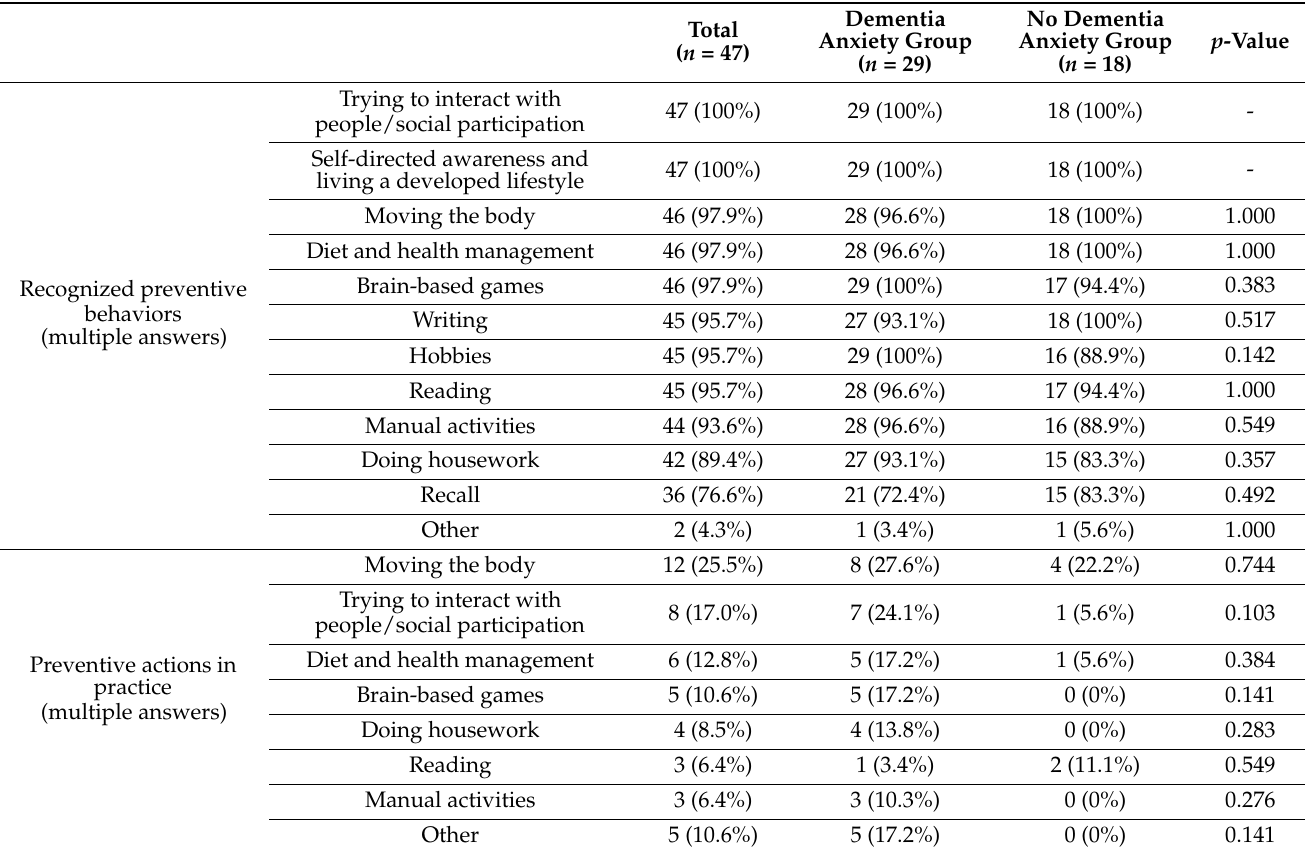
Table 2. Behaviors recognized as dementia-preventing and preventive behaviors